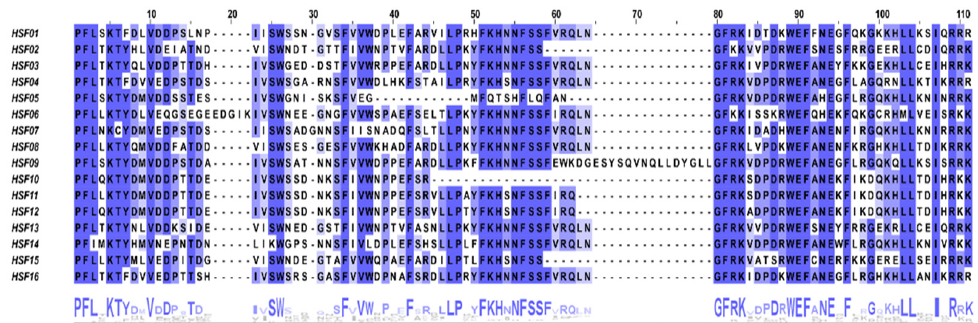
Figure 2. Conserved domain alignment of MsHSF members.